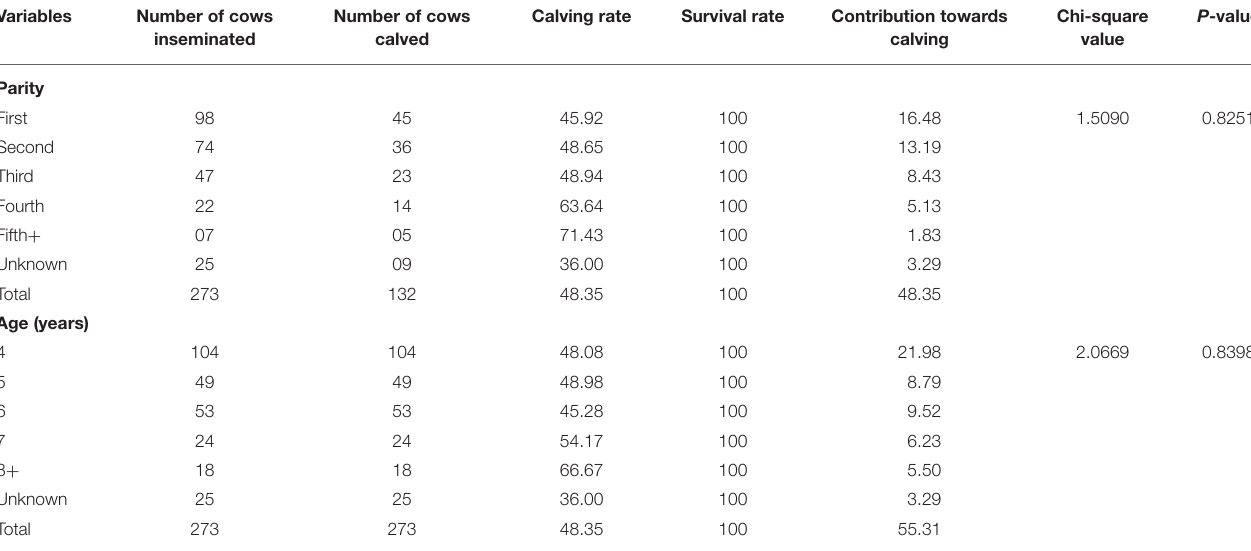
TABLE 7 | Effect of parity and age on calving and survival rate of cows under communal and emerging farming systems. Variables Number of cows Number of cows Calving rate Survival rate inseminated calved